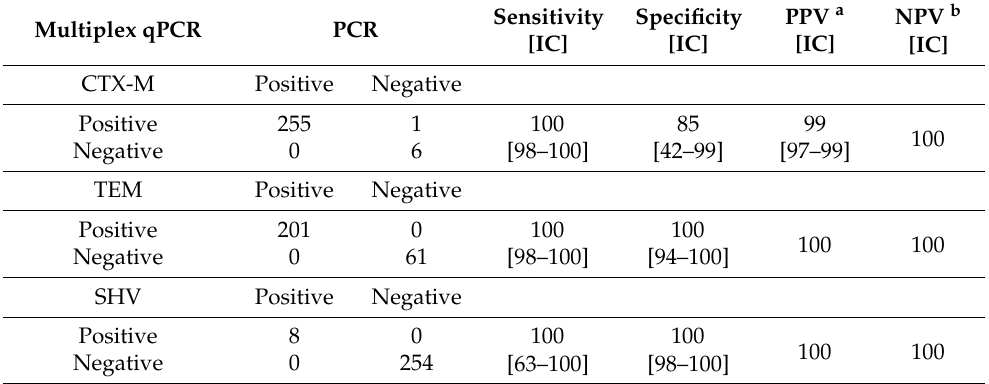
Table 5. Agreement of multiplex qPCR and PCR at detecting bla TEM , bla CTX-M , and bla SHV (n =